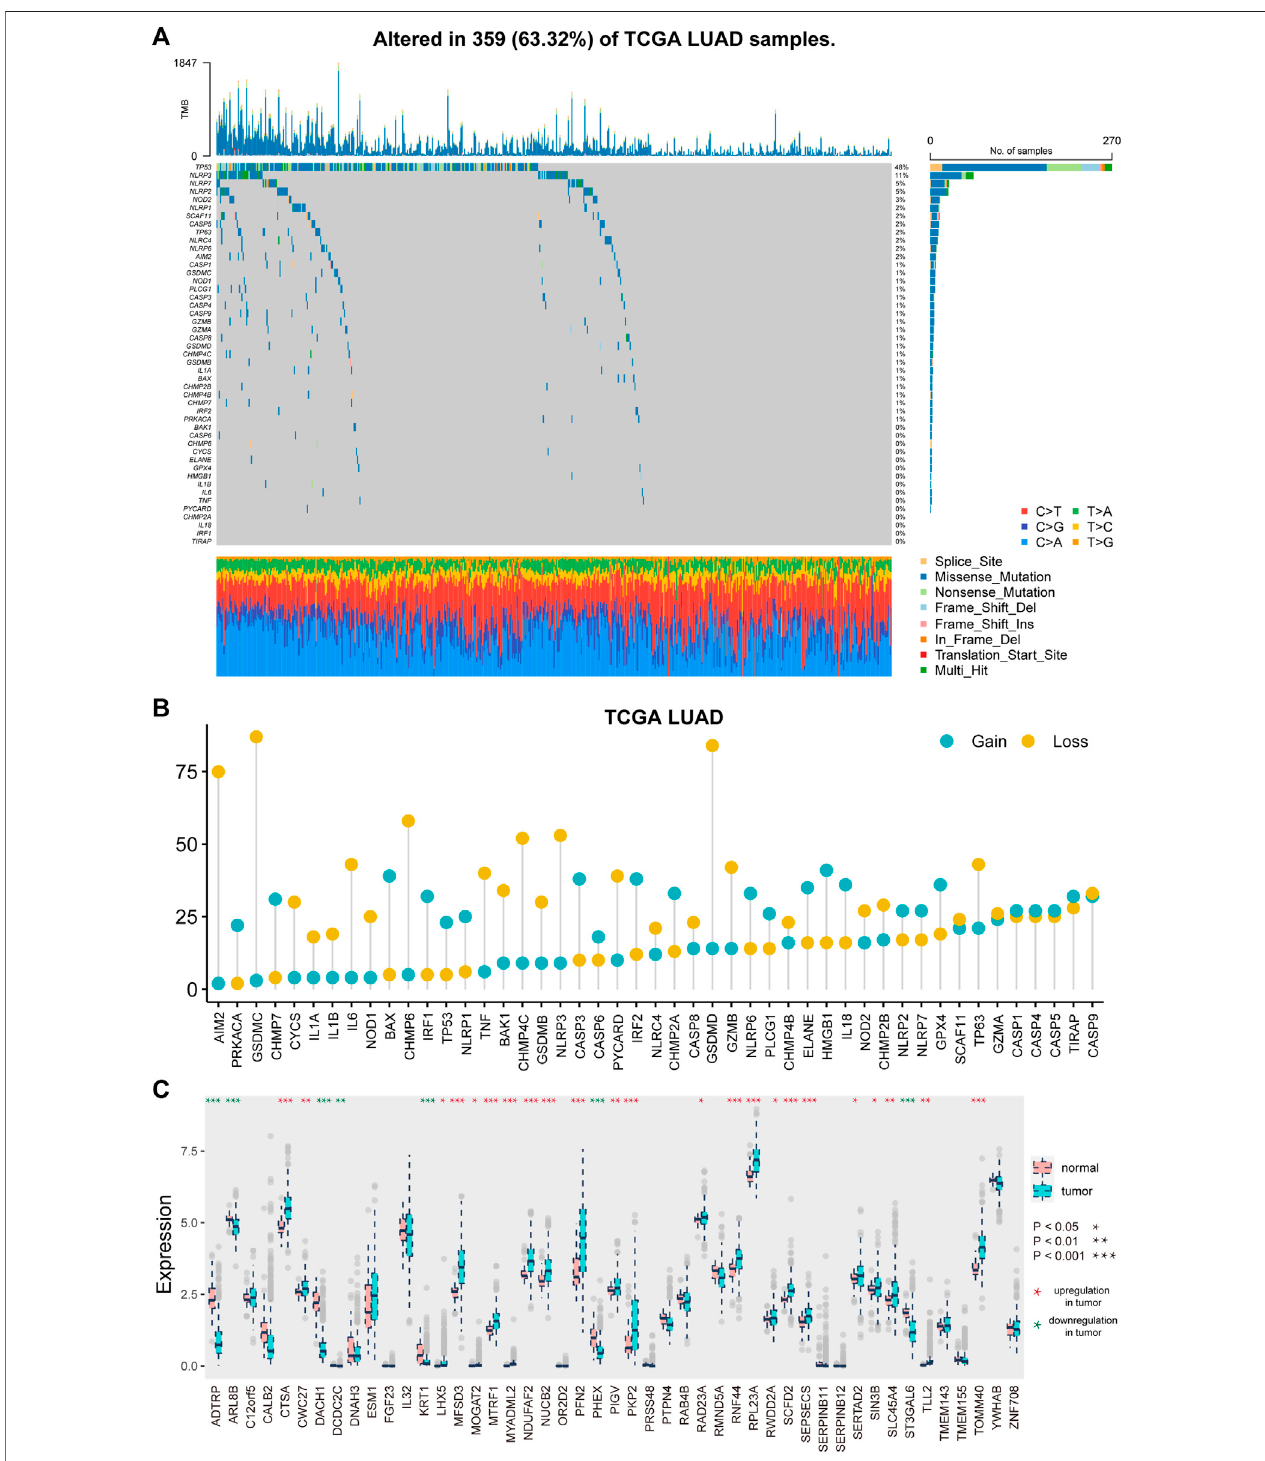
FIGURE 1 | Genetic and transcriptional alterations of pyroptosis-related genes in LUAD. (A) Mutation frequencies of pyroptosis-related genes in LUAD patients of TCGA cohort. (B) Frequencies of CNV gain and loss of pyroptosis-related genes in LUAD patients. (C) Expression distributions of pyroptosis-related genes between tumor and normal